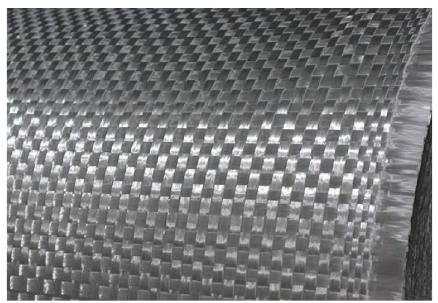
Figure 3: Woven roving laminated sheet.